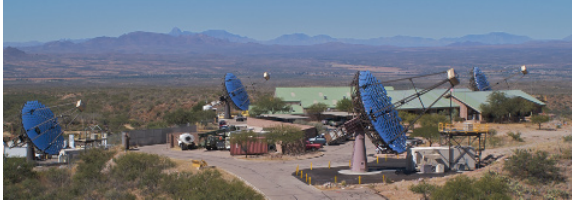
Figure 1. The four VERITAS telescopes located at the base camp of the Whipple Observatory in southern